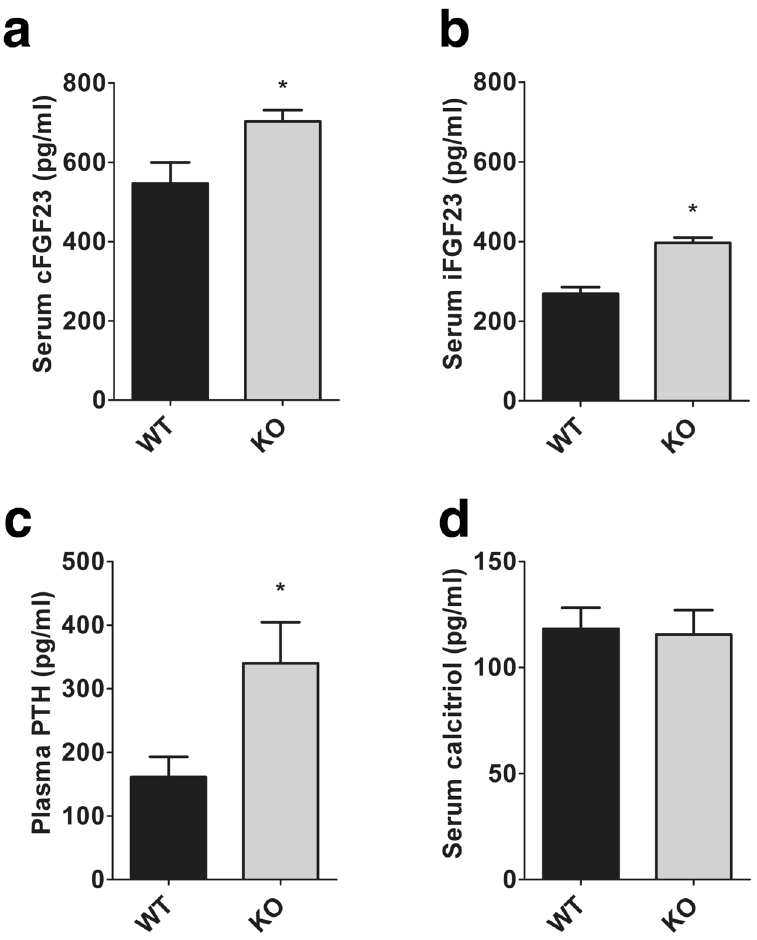
Figure 1. Blood concentrations of cFGF23, iFGF23, PTH and 1,25(OH) 2 D 3 in WT and NCC KO mice. Arithmetic means ± SEM (n = 9–12) of serum cFGF23 ( a ), serum iFGF23 ( b ), plasma PTH ( c ) and serum 1,25(OH) 2 D 3 ( d ) in WT (grey bars) and NCC KO (black bars) under normal diet. * (p < 0.05) indicates significant difference from NCC WT